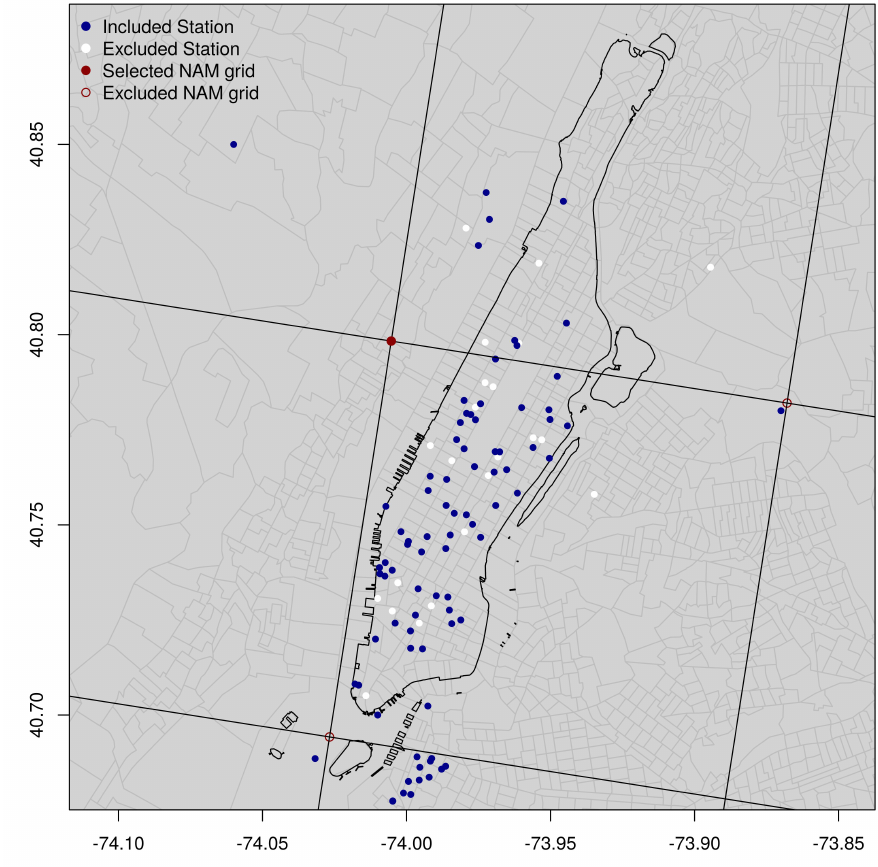
Figure 4. Stations spatial distribution—The blue points represent the PWSs that passed the quality controls and have been included in the analysis; while the white points represent the stations that have been excluded. The three red circles represent the NAM-NMM grid points. The red one is the one selected as a past forecasts